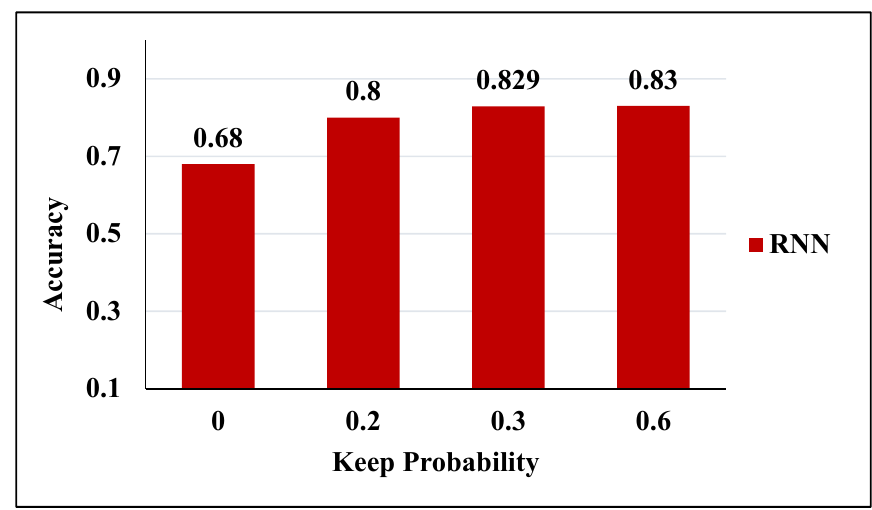
Figure 13. Influence of dropout rate on the performance of the RNN model.